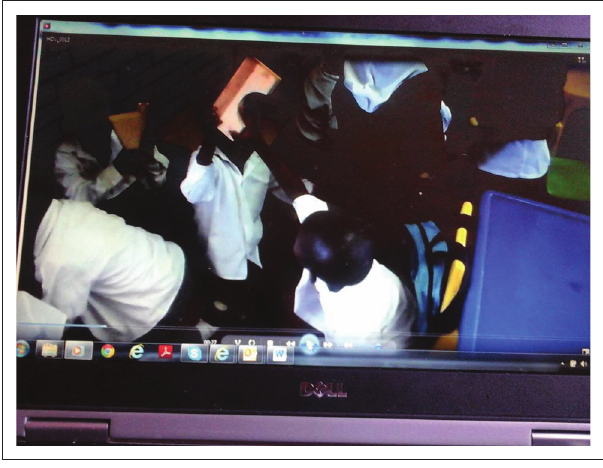
FIGURE 2: Learners ignoring instructions.